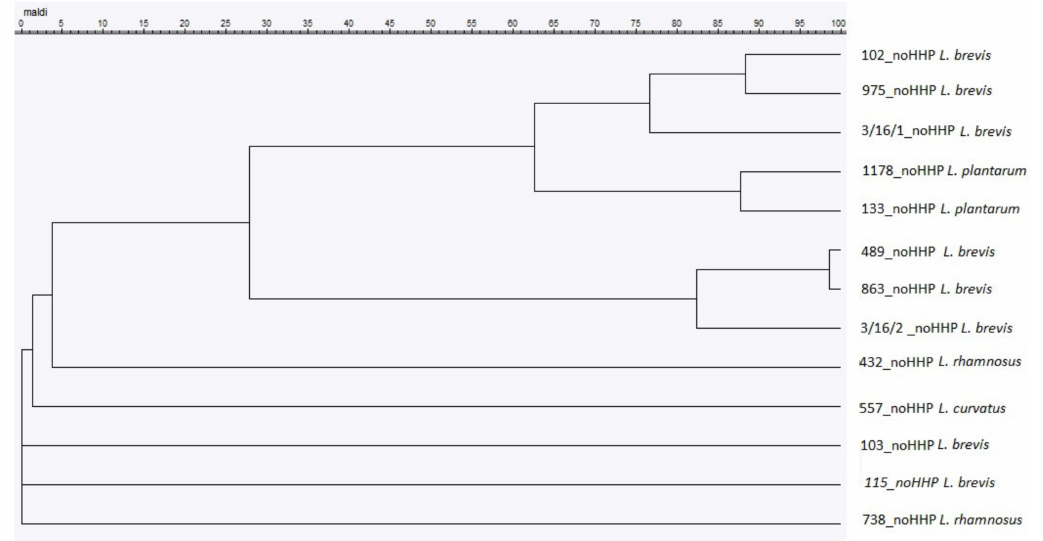
Figure 2. Cluster analysis of the MALDI-TOF MS spectra obtained from the Lactobacillus strains included in this study. In the MSP dendrogram, the relative distance between the strains is displayed as arbitrary units, where 100 indicates complete similarity and 0 indicates maximum